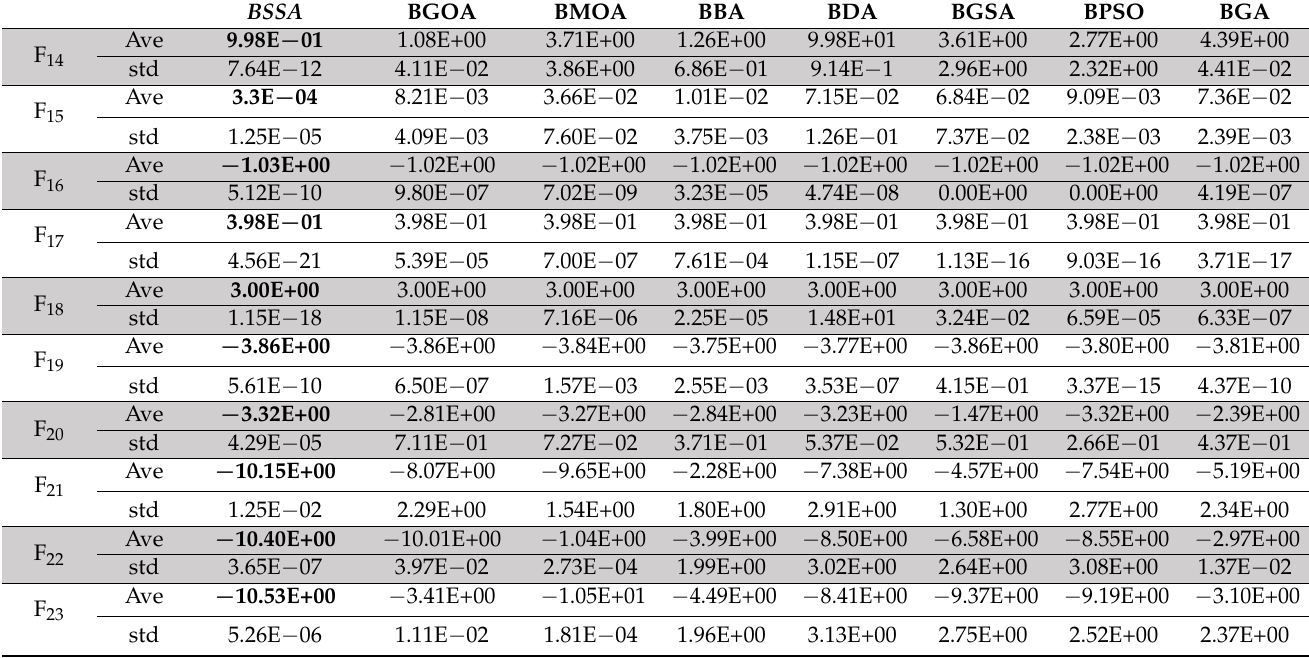
Table 7. Results for the BSSA and other algorithms in multimodal test functions with fixed